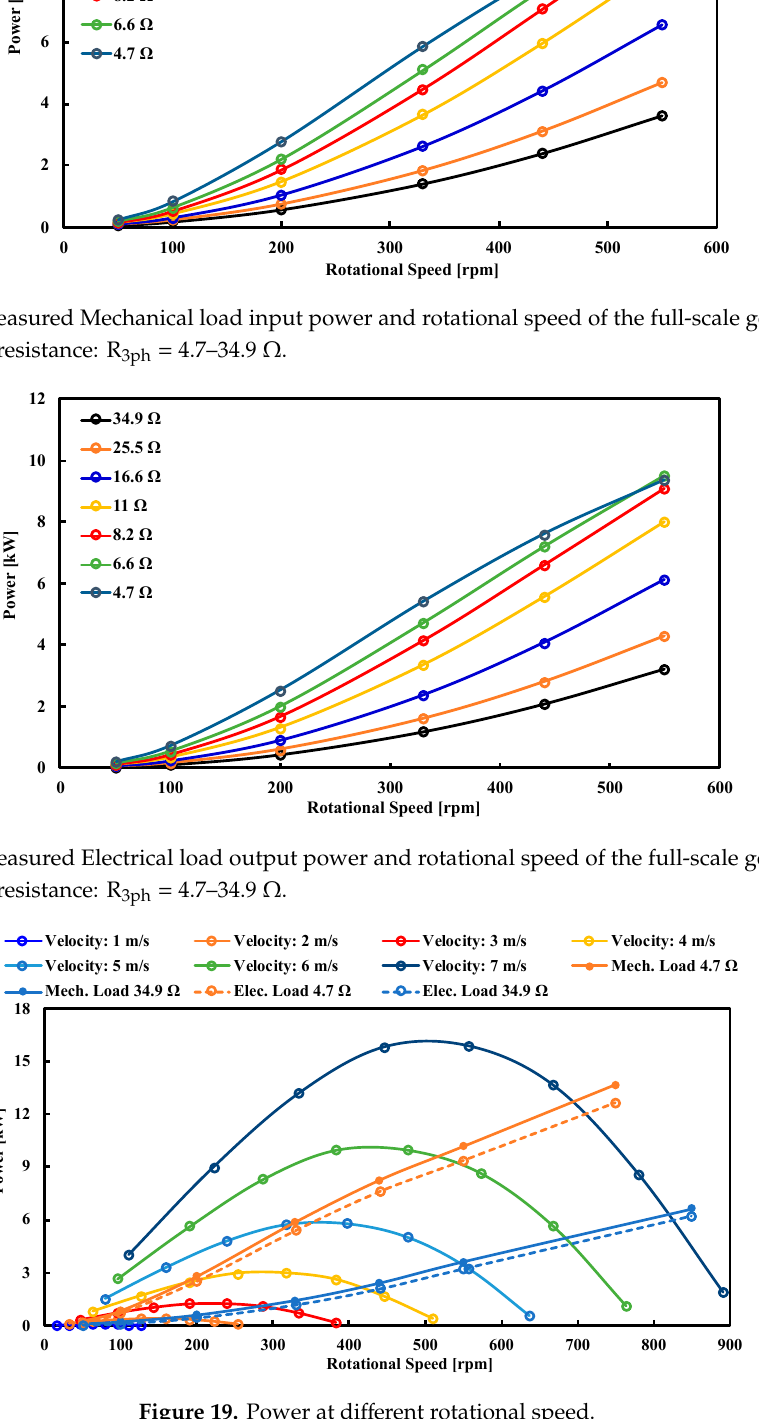
Figure 19. Power at different rotational speed.